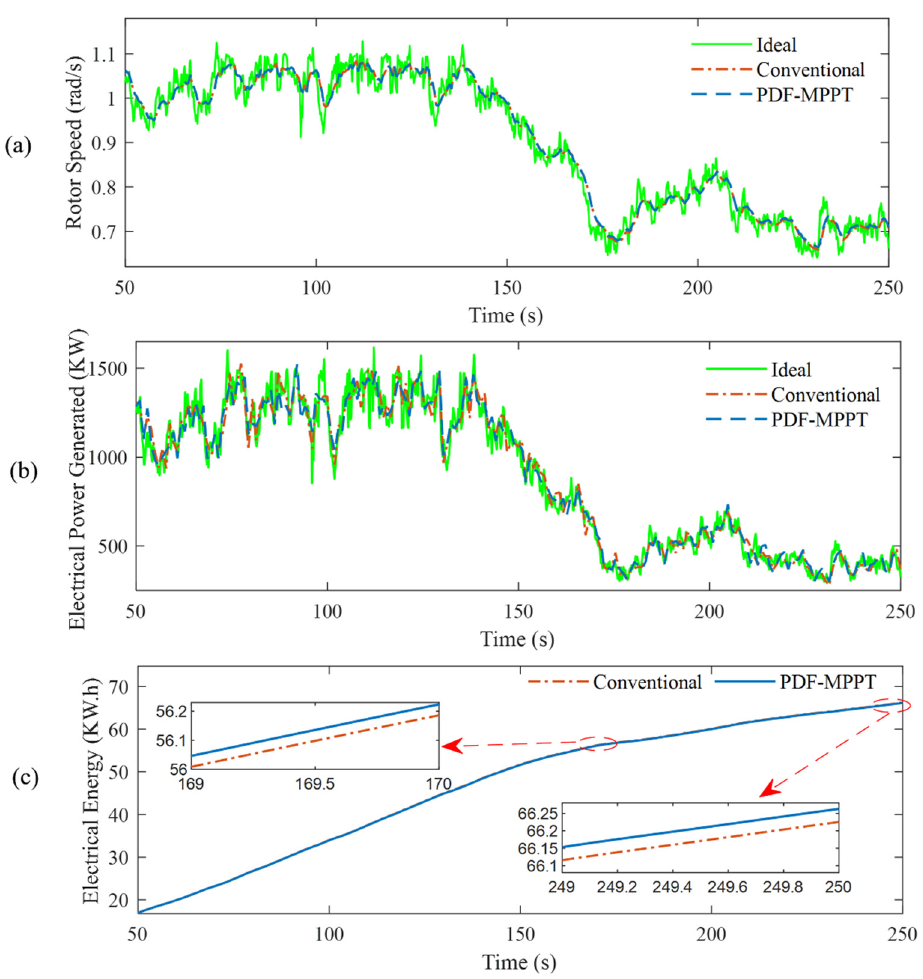
Figure 8. Simulation result using PDF-MPPT method and conventional MPPT method for the turbulent wind speed with changed average value: ( a ) rotor speed; ( b ) electrical power generated; ( c ) cumulative generation of using PDF-MPPT method compared with using the conventional MPPT method. The green line with the legend of “ideal”, the blue line with the legend of “conventional” and the brown line with the legend of “PDF-MPPT” in ( a – c ) means the corresponding performance index in ideal operation state, using the conventional MPPT method and using the novel MPPT method, respectively.